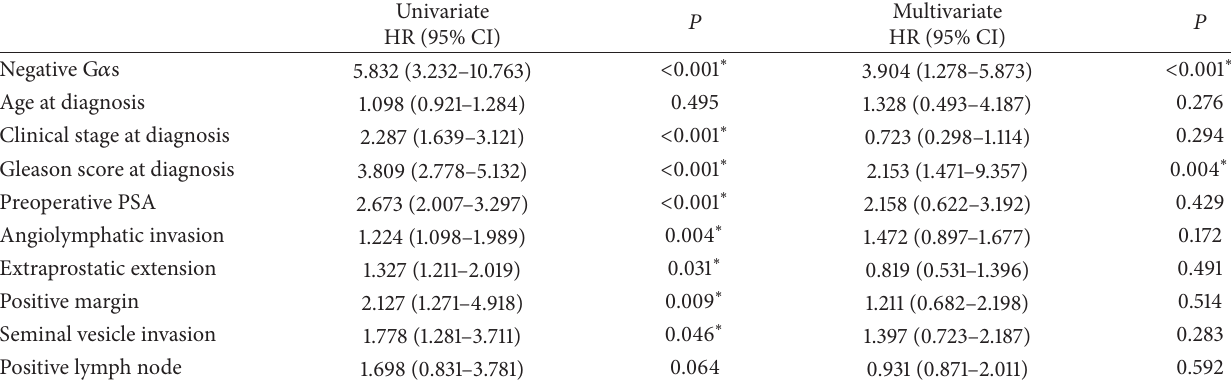
Table 5: Univariate and Multivariate analysis of clinical factors in relation to overall survival.